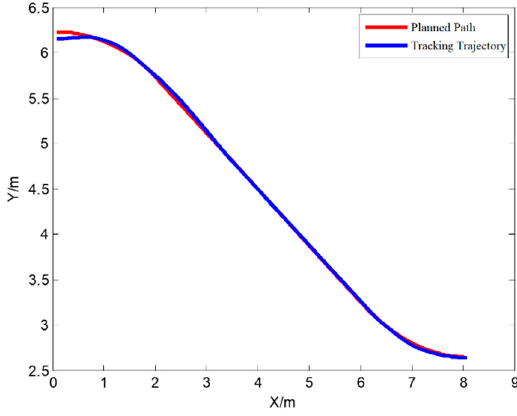
Figure 17. Co-Simulation Experiment Results.